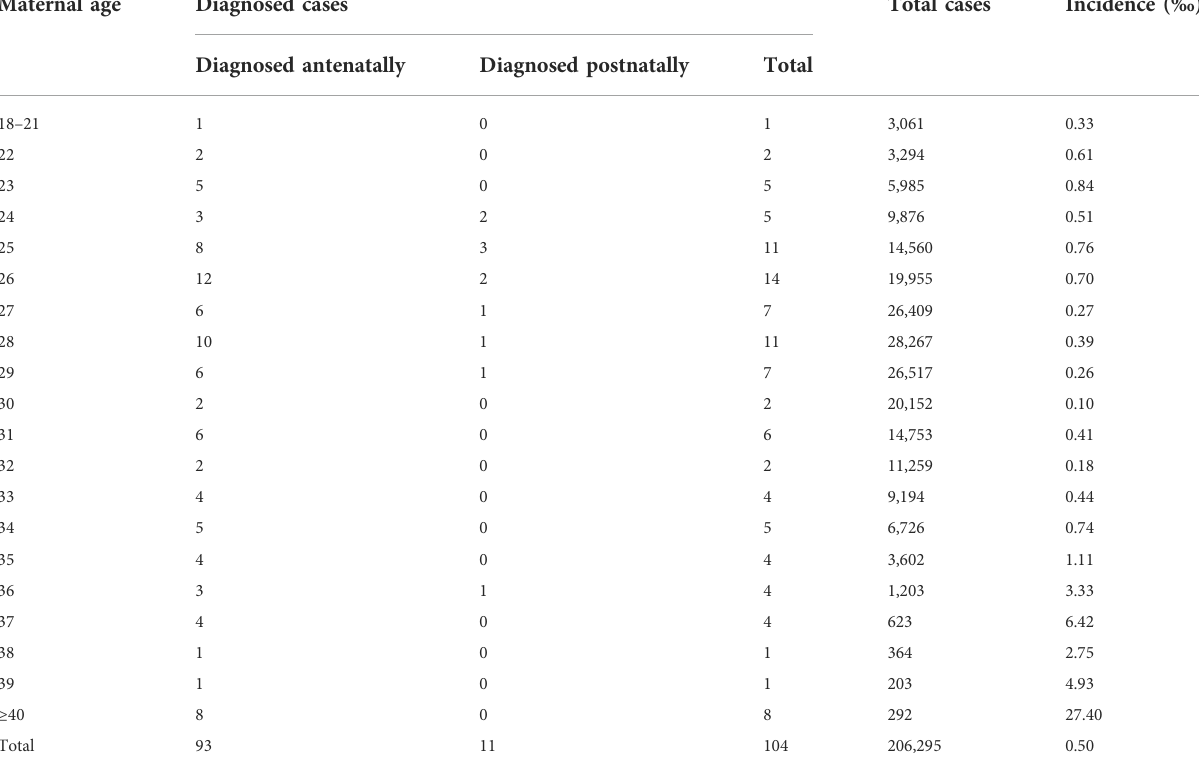
TABLE 1 Incidence of DS by maternal age.